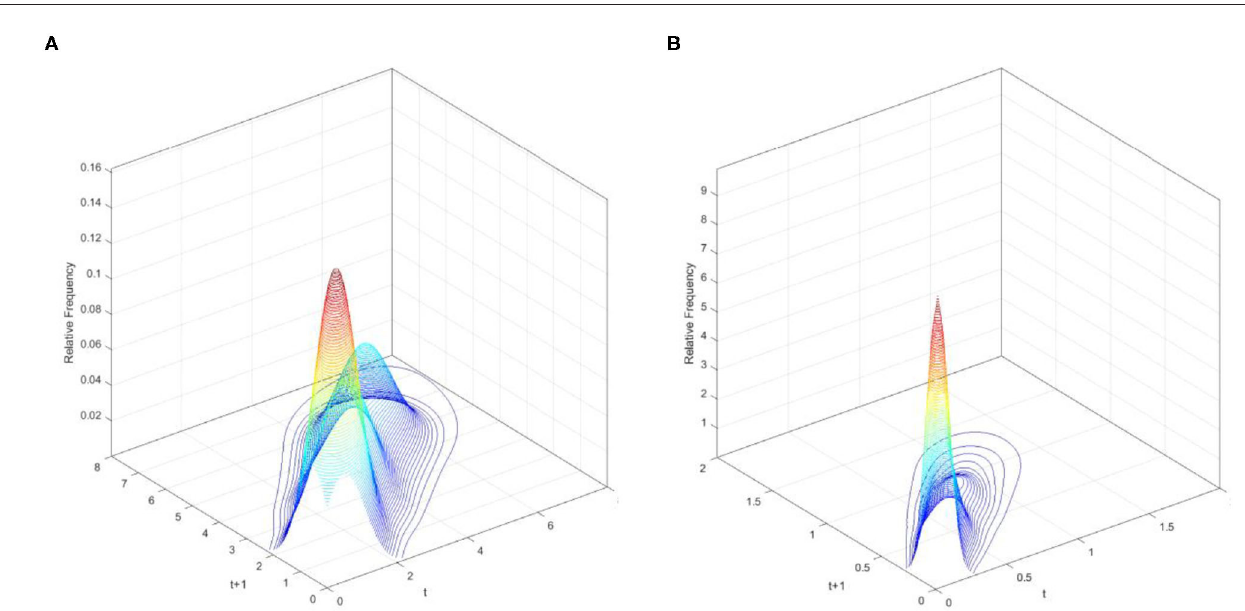
FIGURE 5 | Three-dimensional plot of transition probability kernel for the relative RIVAPC of countries for the Global North and the Global South with annual transitions. Source: authors’ calculation. N.B. The vertical axis indicates the probability of transition at the country level from one RIVAPC value in year t to another RIVAPC value in year t + 1. (A) Global North. (B) Global